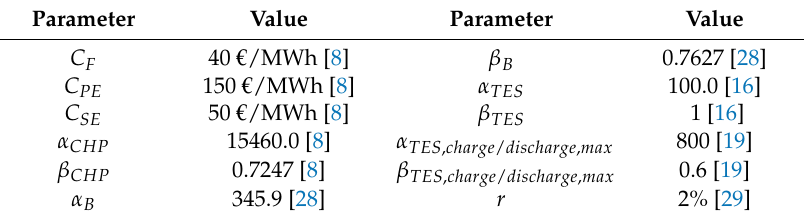
Table 3. Prices of energy carriers and investment costs